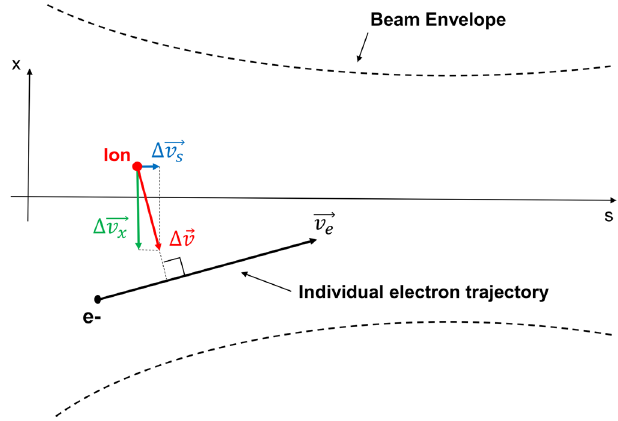
FIG. 1. The ion-beam interaction, the force felt by the ion is perpendicular to the local direction of the electron